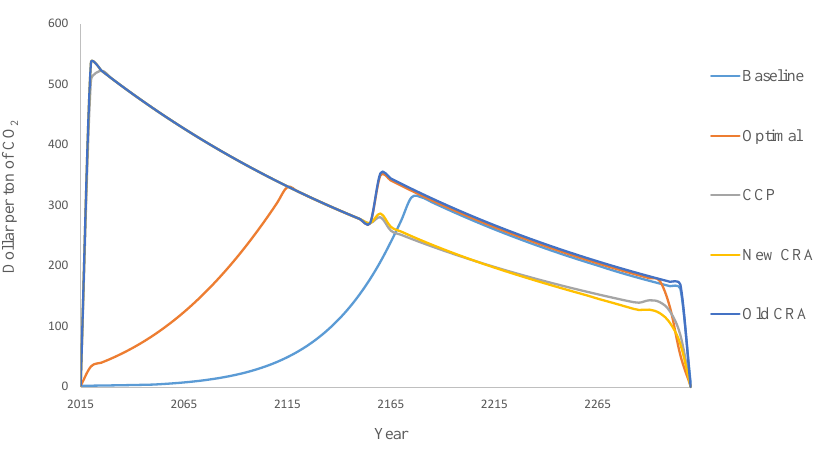
Figure 3. The carbon price paths for no learning cases under the baseline, optimal, CCP, New CRA, and Old CRA